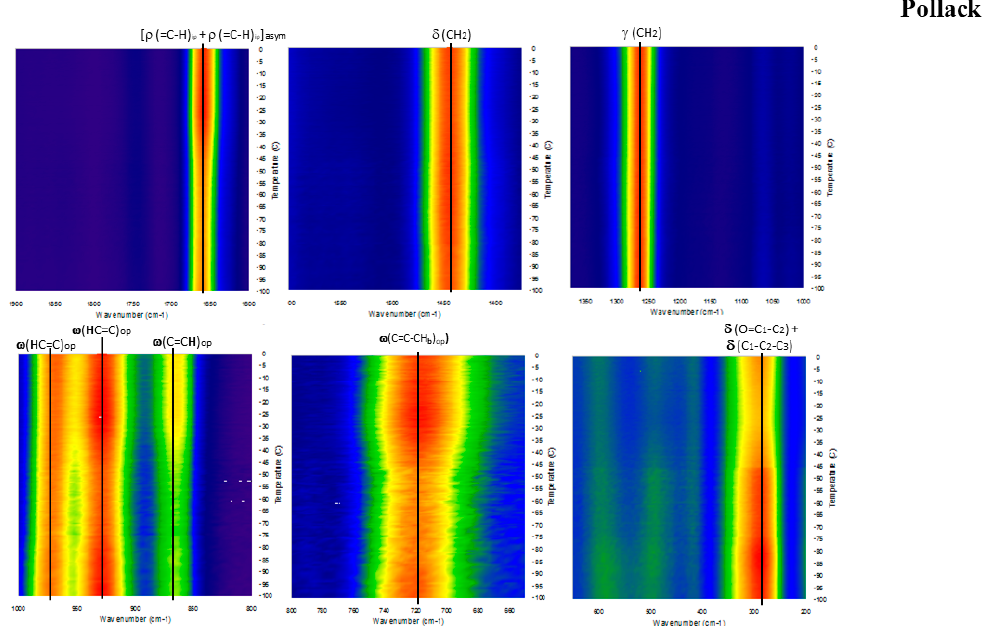
Figure 6. GTRS contour plot, Alaskan pollack oil concentrate (PO). Note, minor Raman mode intensity change and line broadening that correlate with heat flow data in Figure 1.